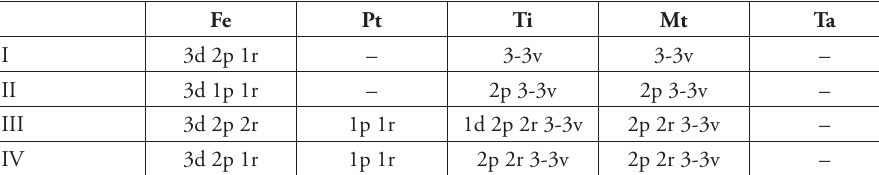
Palp as in Fig. 1: patellar apophysis long, more than half length of tibia; tibia short, about 1/4 length of tarsus; VTA subequal to the tibial length, without pointed tip, ex- tending beyond the tibia; RTA short, about 1/6 length of VTA; cymbial furrow long, more than half length of cymbium; conductor broad and with two spiraling loops; median apophysis broad and nearly triangular; embolus with broad base originating